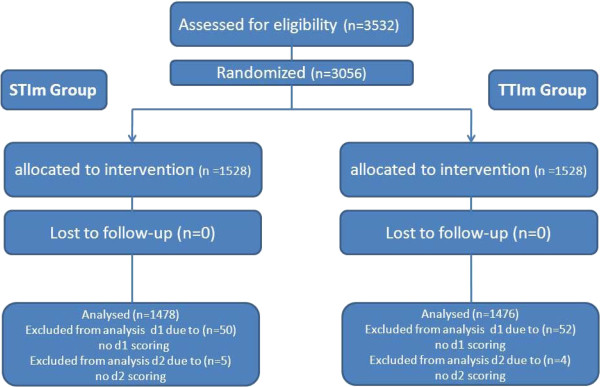
Flow diagram of randomization of oocytes prior to ICSI.